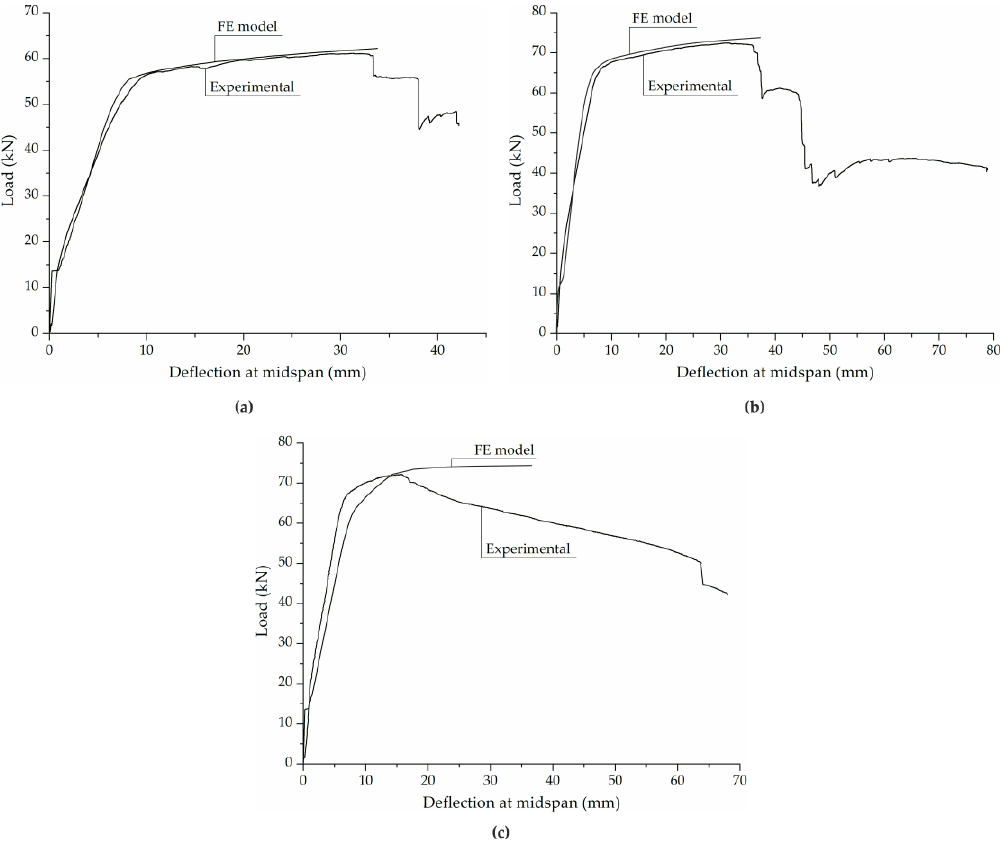
Figure 15. Experimental and FE load-deflection responses for slabs ( a ) S1; ( b ) S2; ( c ) S3. Table 7. Comparison between experimental and finite element